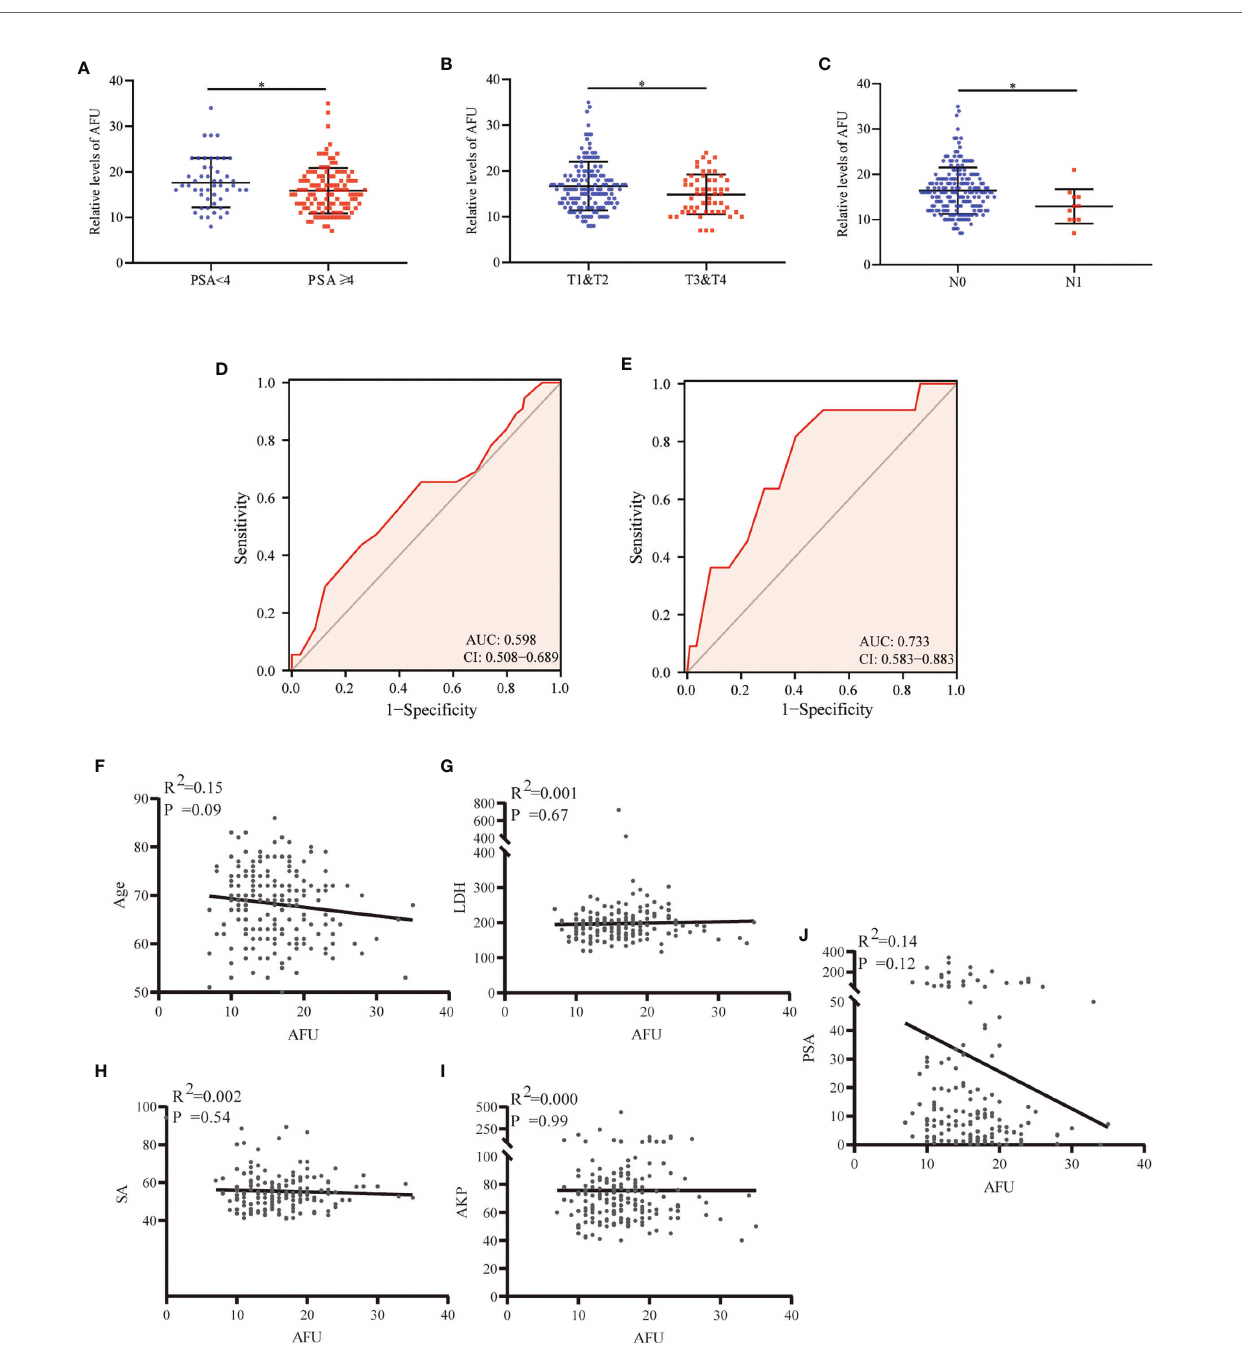
FIGURE 2 | AFU expression in PCa subgroups. (A) PSA. (B) T stage. (C) N stage. (D) The diagnostic value of AFU for advanced T stage. (E) The diagnostic value of AFU for lymph node metastasis. Line correlations among AFU and PCa patient ’ s variables: (F) age; (G) LDH; (H) SA; (I) AKP; and (J) PSA. * p < 0.05. AFU, alpha- L -fucosidase; PCa, prostate cancer; PSA, prostate-speci fi c antigen; LDH, lactate dehydrogenase; SA, serum sialic acid; AKP, alkaline